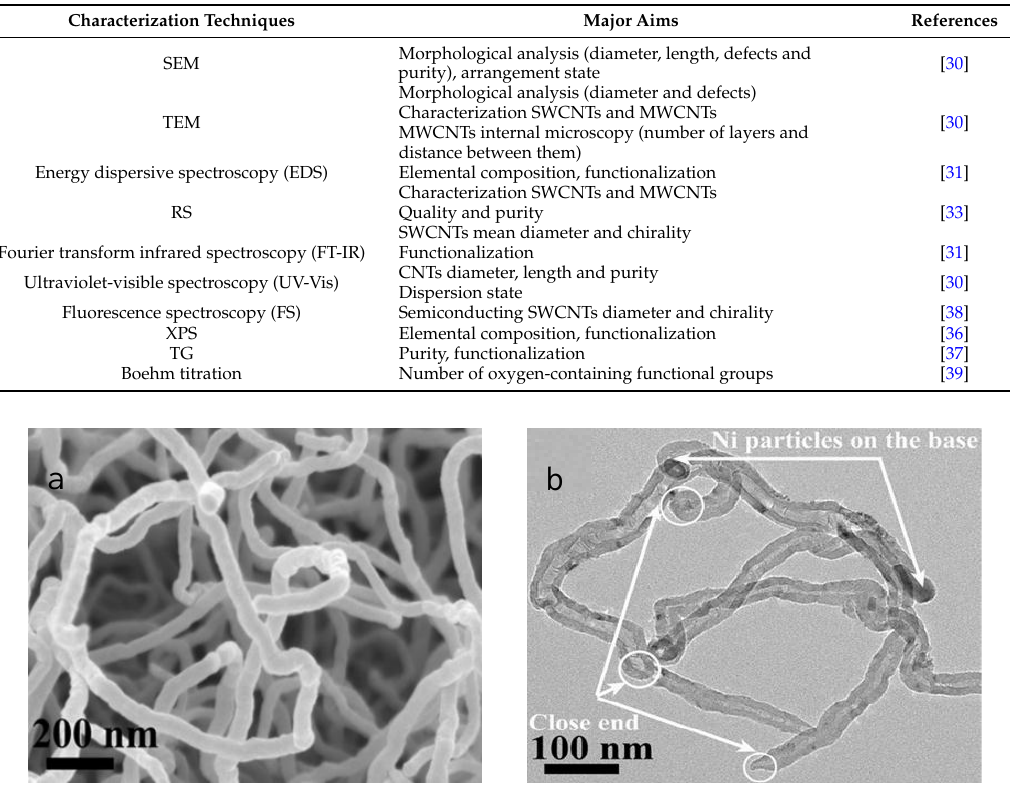
Figure 5. ( a ) SEM image and ( b ) TEM image of CNTs [32].